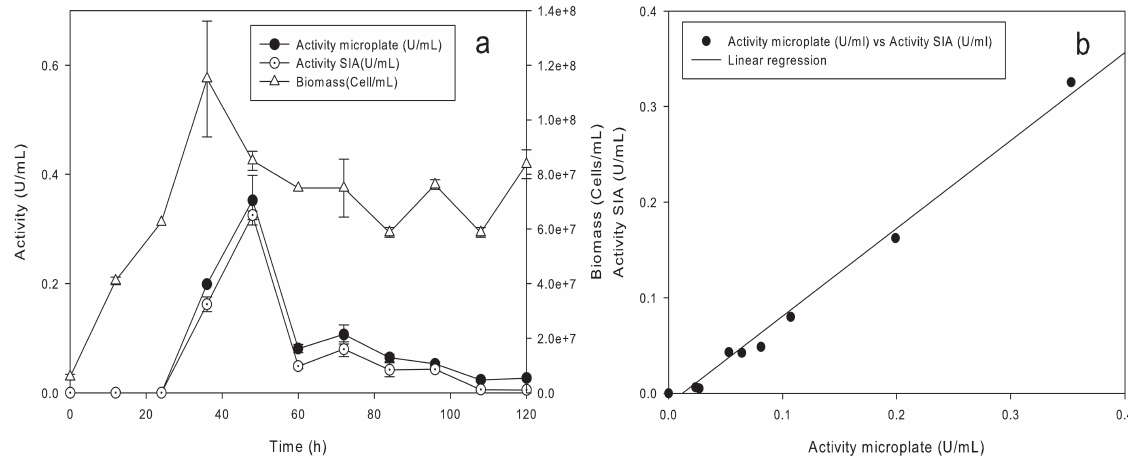
Figure 6. Monitoring the Yarrowia lipolytica fermentation with the SIA